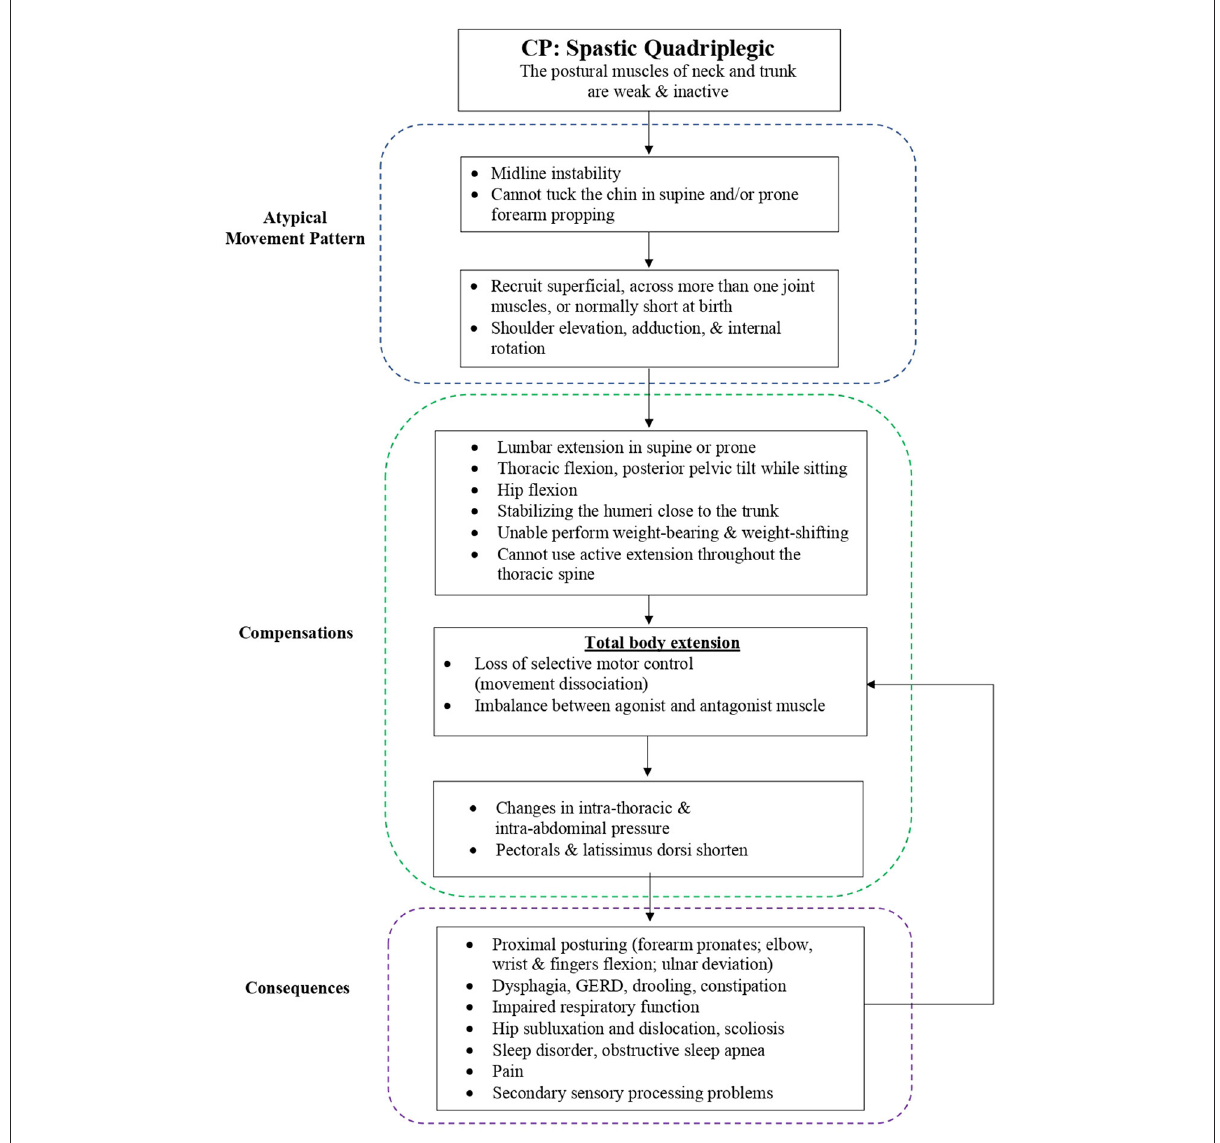
FIGURE2 Mechanism of atypical movement pattern, multisystem compensations, and consequences of spastic quadriplegic cerebral palsy in